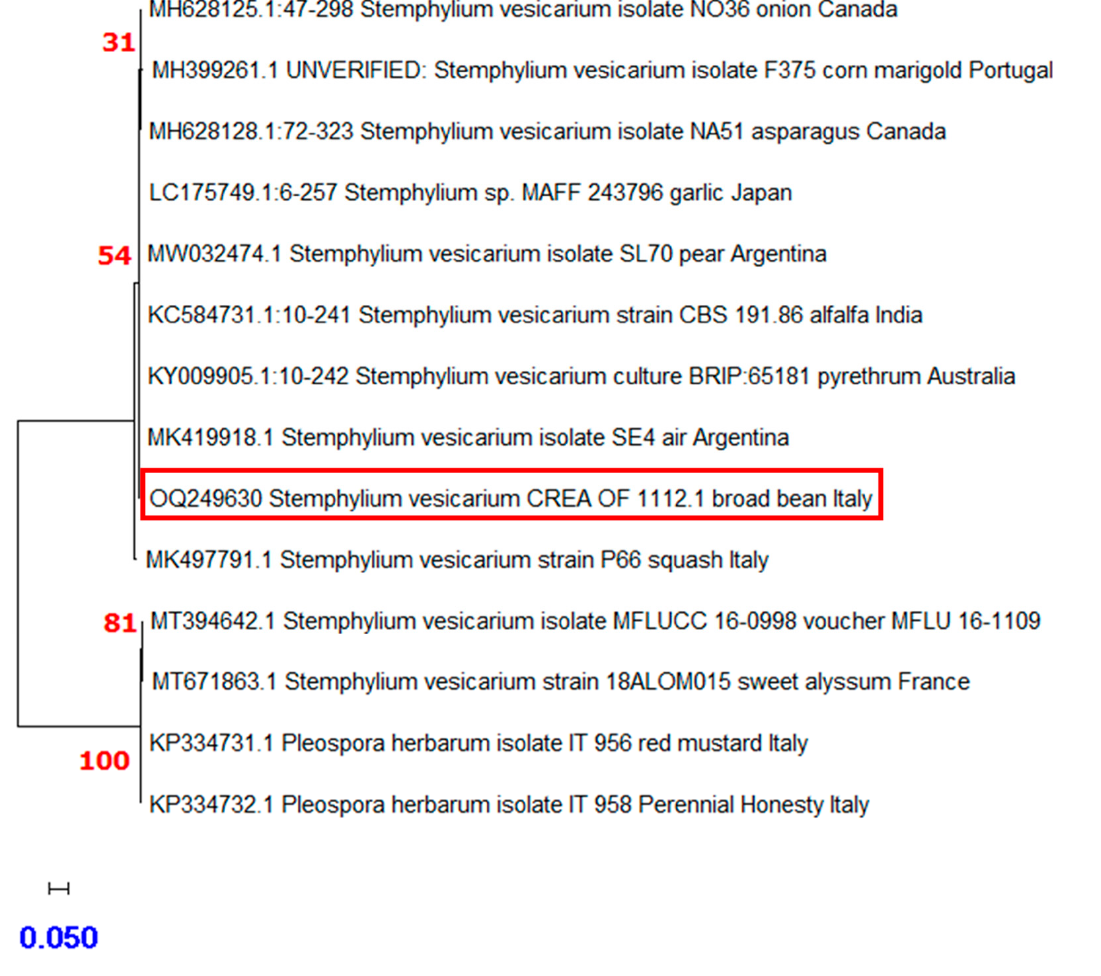
Figure 9. The evolutionary history inferred for S. vesicarium CREA OF 1112.1 based on TEF 1 - α was performed by using the maximum likelihood method and the Tamura–Nei model. The tree with the highest log likelihood ( − 665.65) is shown. The percentage of trees in which the associated taxa clustered together is shown next to the branches. Initial tree(s) for the heuristic search were obtained automatically by applying the Neighbor-Join and BioNJ algorithms to a matrix of pairwise distances estimated using the Tamura–Nei model, and then selecting the topology with the superior log likelihood value. The tree is drawn to scale, with branch lengths measured in the number of substitutions per site (next to the branches). This analysis involved 13 nucleotide sequences. Codon positions included were 1st+2nd+3rd+Noncoding. There was a total of 733 positions in the final dataset. Red squares highlight the position of S. vesicarium CREA OF 1112.1. Numbers in red indicates the bootstraps for the nodes and the scale bar was reported in blue. Phylogenetic analyses were conducted in MEGA X.